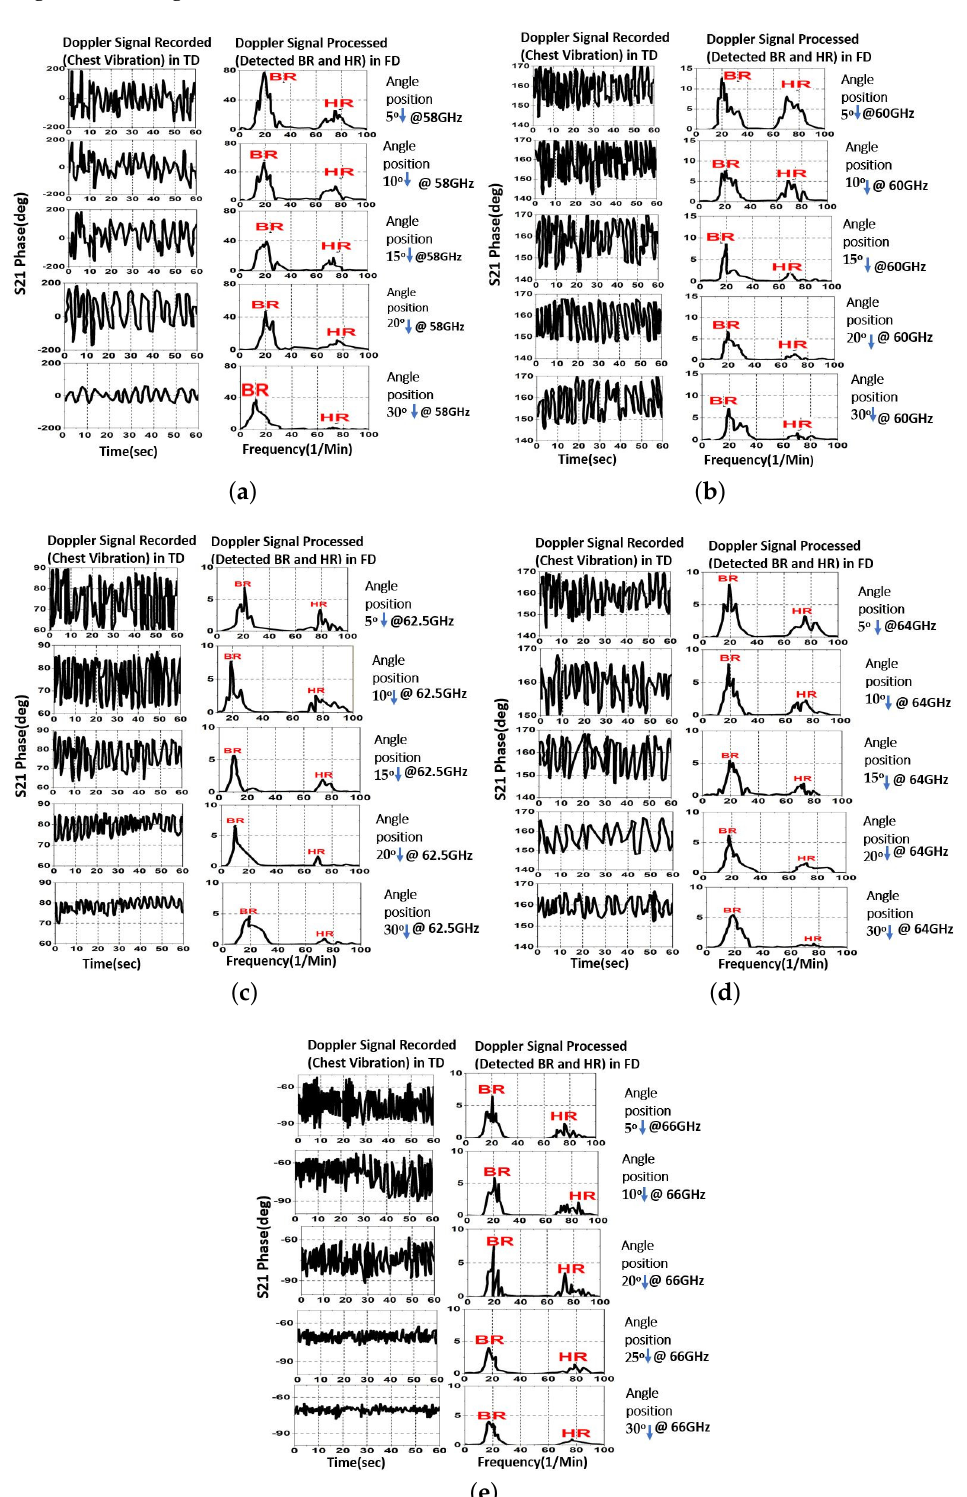
Figure 14. Measured RVSM results from 2 m distance at ( a ) 58 GHz, ( b ) 60 GHz, ( c ) 62.5 GHz, ( d ) 64 GHz, and ( e ) 66